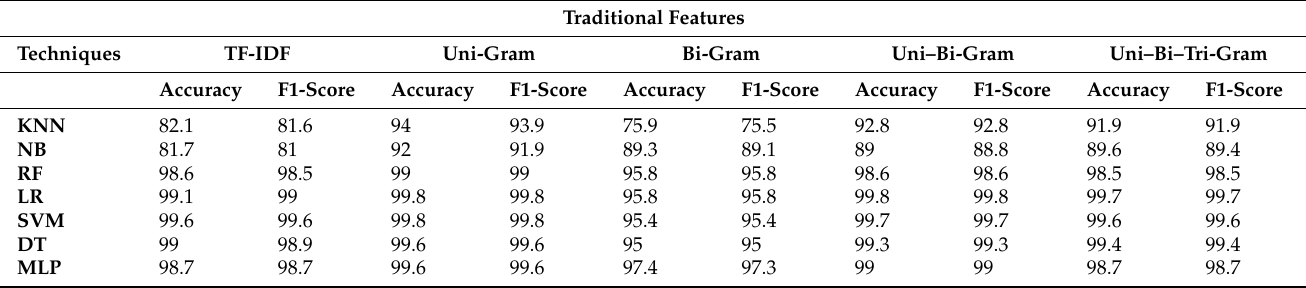
Table 6. Results of machine learning classifiers with raw binary